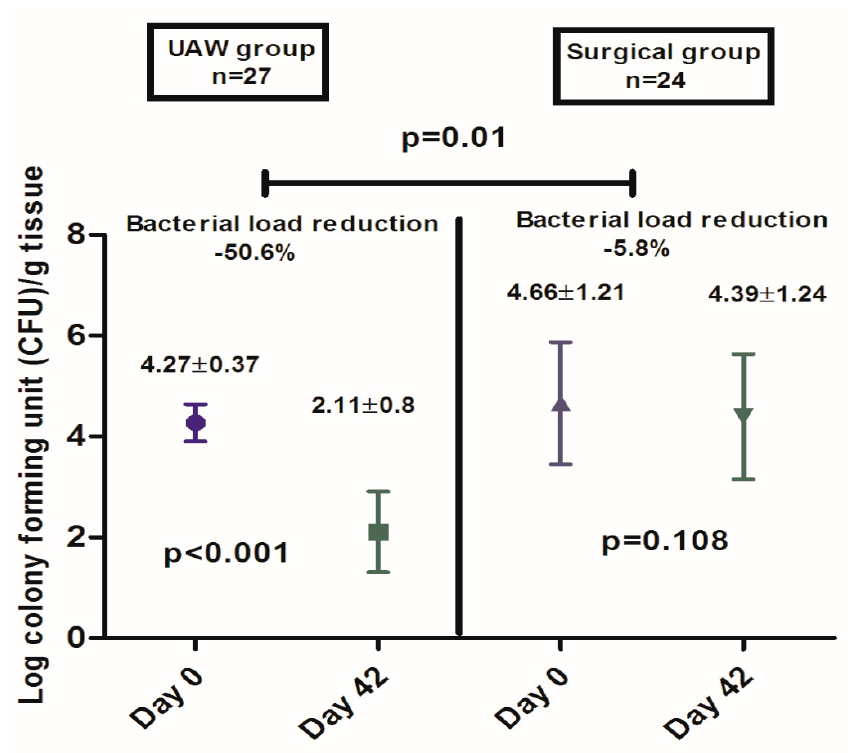
Figure 6. Comparison of bacterial loads in diabetic foot ulcer tissue samples at patient inclusion (Day 0) and after six-week treatment period (Day 42) after UAW or surgical debridement. The rates of patients that were healed after 6 months of follow-up were similar in both groups (23 patients [85.1%] in the UAW group vs. 20 patients [83.3%] in the surgical group; p = 0.856). Time to healing was significantly lower ( p = 0.04) in the UAW group (9.7 ± 3.8 weeks) than in the surgical group (14.8 ± 12.3